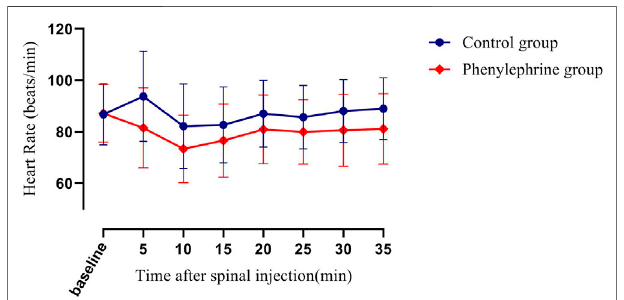
FIGURE 3 | The baseline heart rate and the heart rate in the fi rst 35 min after spinal induction is presented for the two groups. The area under the curve(mean ± SD)wassigni fi cantlydifferentwhencomparedbetweenthetwo groups (3,599 ± 141 and 3,927 ± 144 min × beats/min in the phenylephrine and control groups, respectively, p (cid:1) 0.0003).